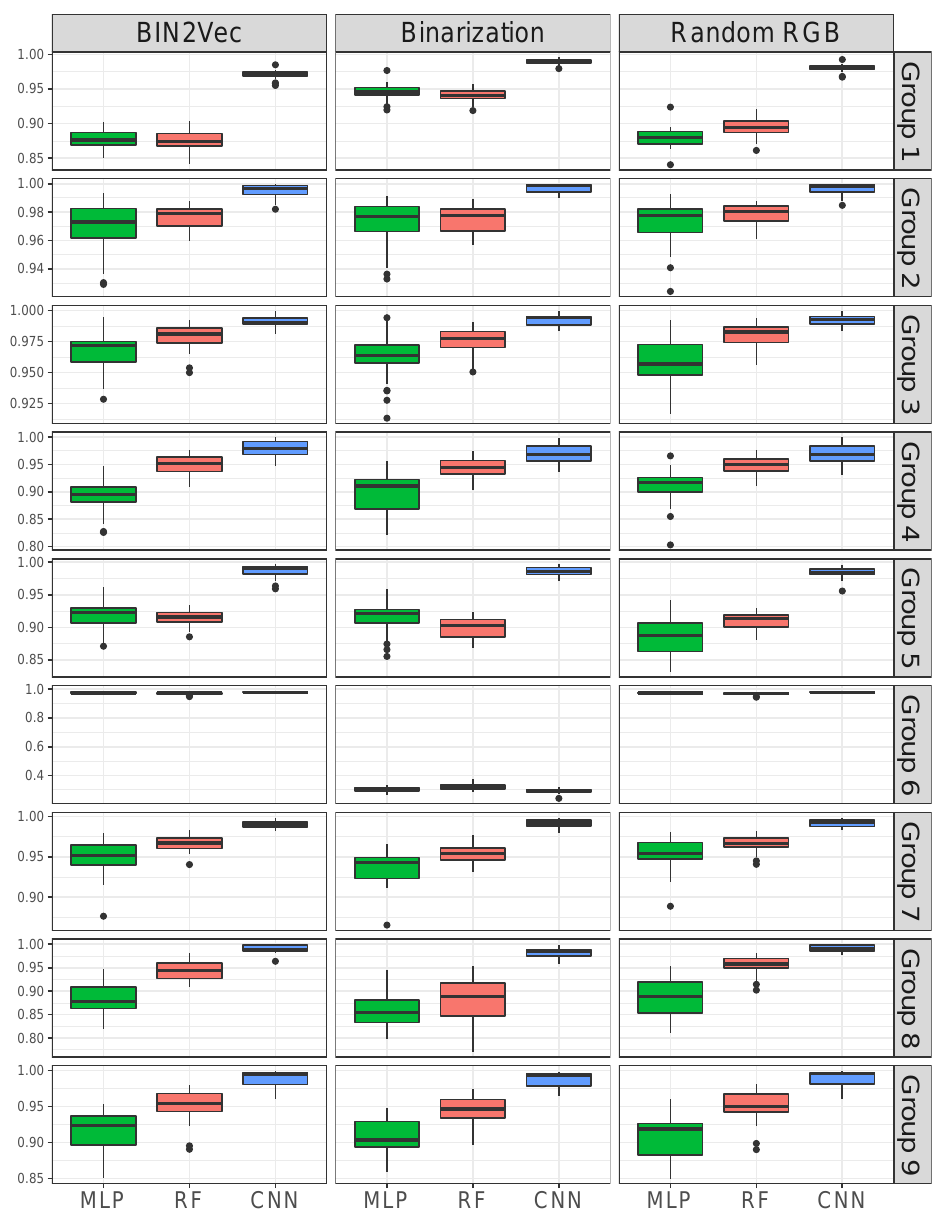
Figure 15. Box plot of DNN, RF, CNN, AUC results based on 1 ∼ 9